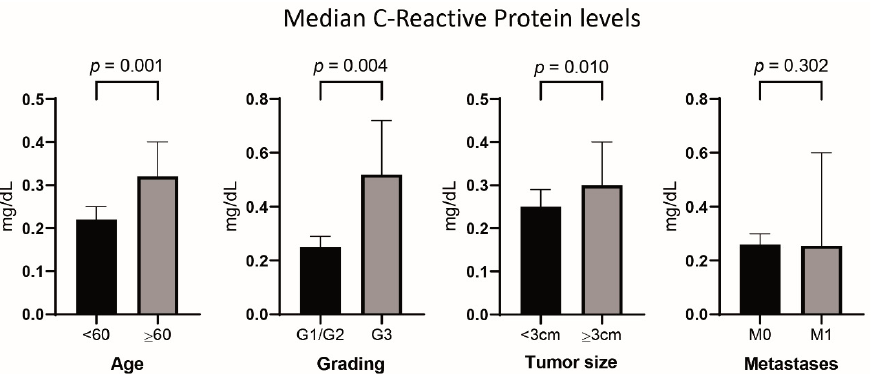
Figure 1. C-reactive protein levels in the whole cohort stratified by patients’ age, grading, tumor size, and presence of metastases (bar charts indicate median values and 95% confidence intervals).